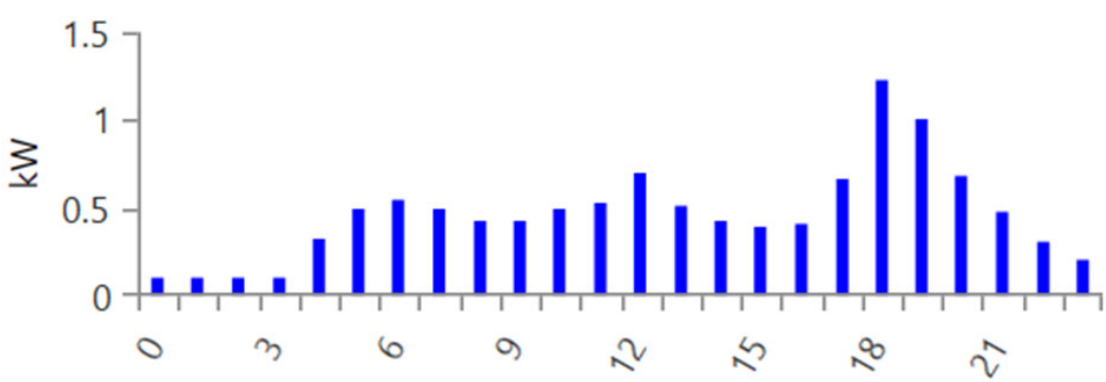
Figure 4. Household load pattern for average daily load (example).